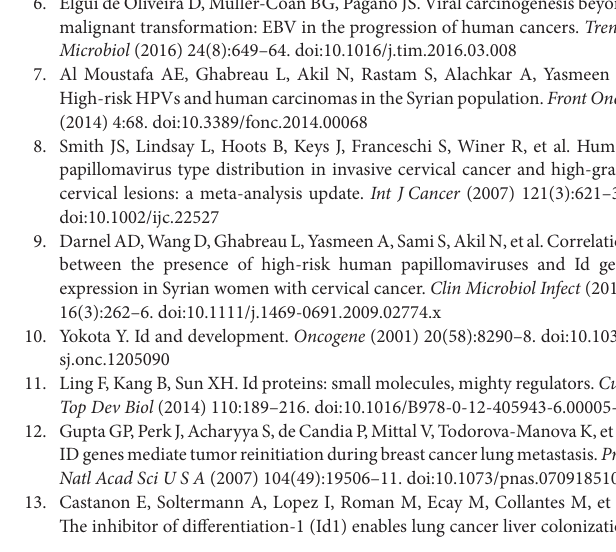
FigUre s1 | Representative polymerase chain reaction reactions for LMP1 of Epstein–Barr virus (EBV) in four cervical cancer samples. Chronic B leukemia cells were used as a positive control (PC); human normal cervical cells were utilized as negative control